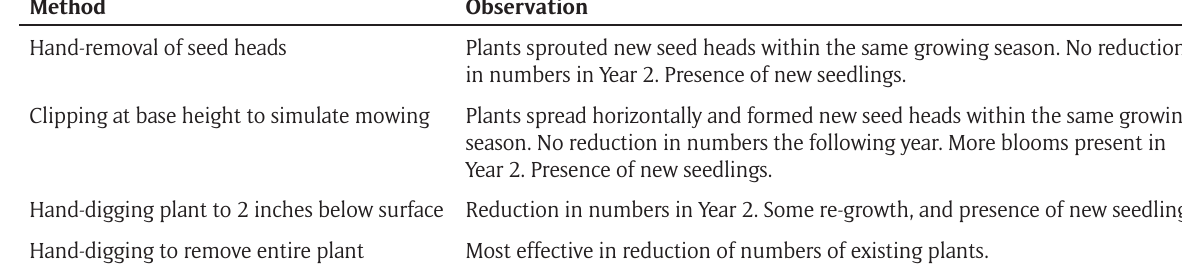
Table 1: Summary of control method observations. Method Observation Hand-removal of seed heads